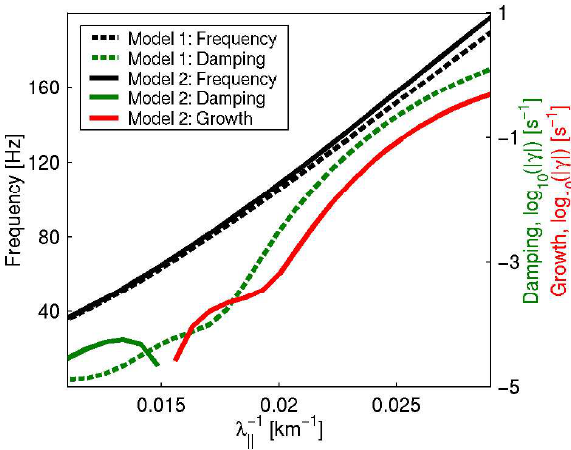
Fig. 11. The dashed and solid black lines show frequency as a func- tion of parallel inverse wavelength for Model 1 and Model 2 respec- tively. The dashed green line is the damping rate versus λ − 1 k for Model 1, where only the T k >T ⊥ anisotropy is included. Damp- ing (green solid line) and growth (red solid line) rates for the second model show that the T ⊥ > T k anisotropy are able to generate the observed waves.